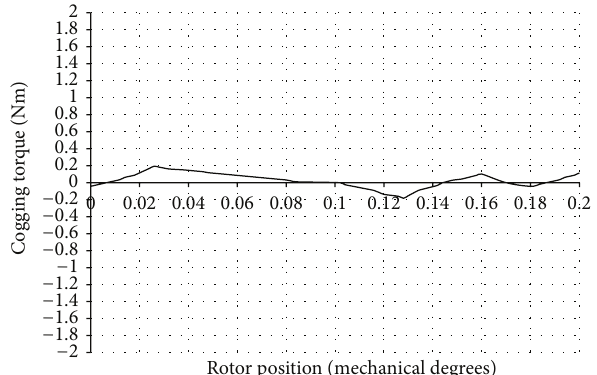
Figure 11: Cogging torque waveform after combined effect.